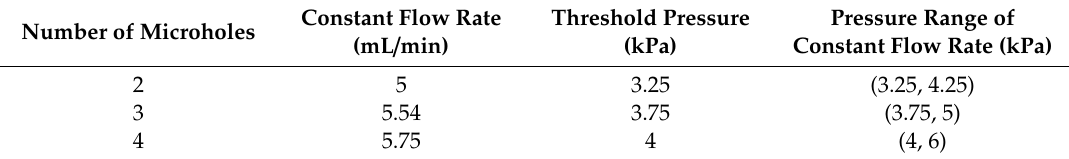
Table 2. Comparison of regulation performance of flow rate with varying numbers of microholes.